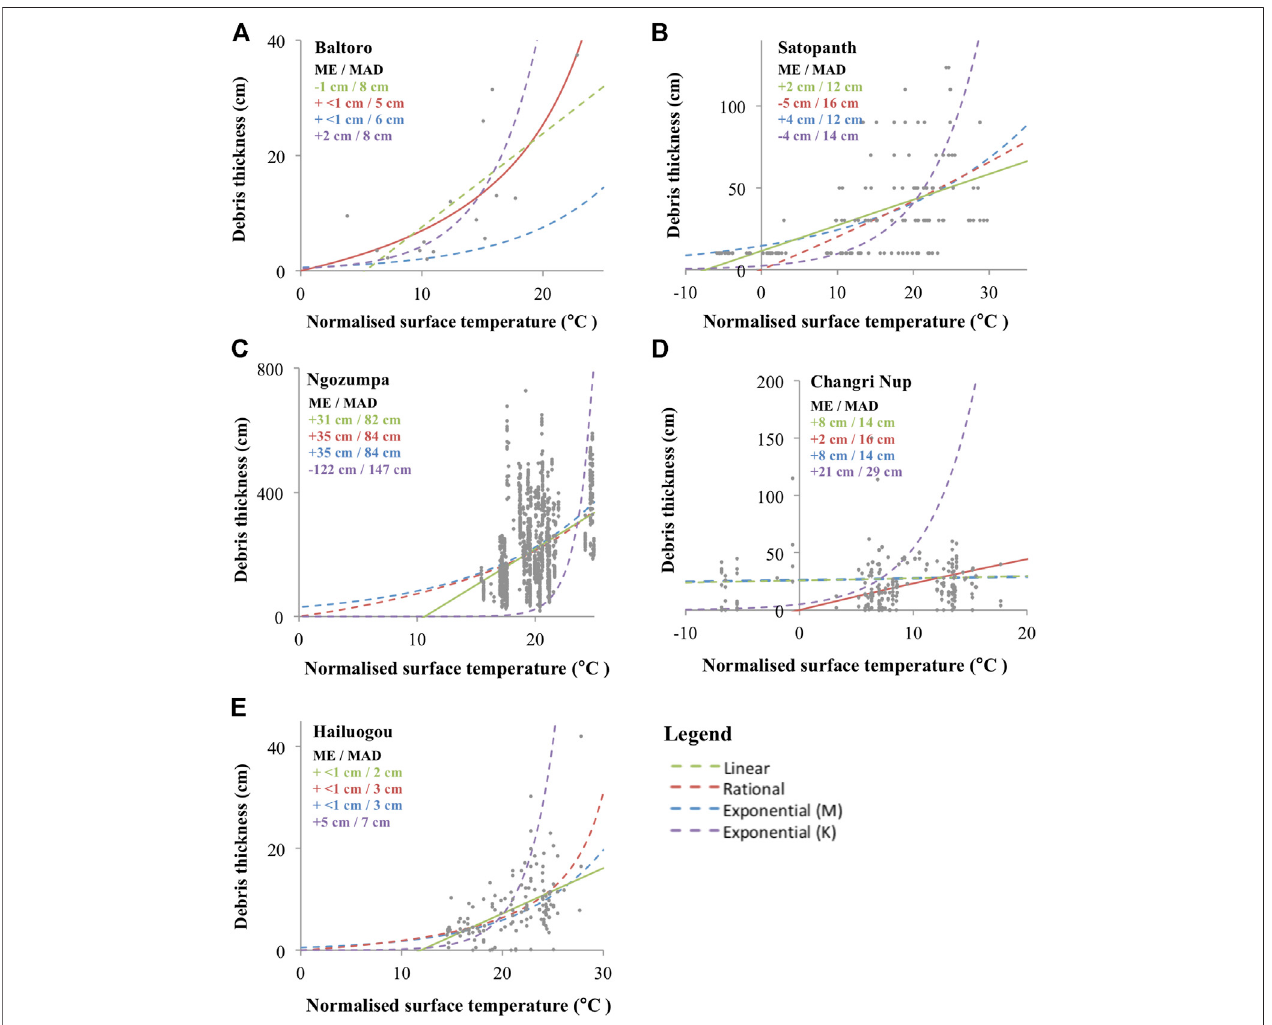
FIGURE 4 | Comparison of the errors of the linear (green), rational curve (red), exponential (M) (blue), and exponential (K) (purple) forms of the relationship between debris thickness and surface temperature for (A) Baltoro Glacier, (B) Satopanth Glacier, (C) Ngozumpa Glacier, (D) Changri Nup Glacier, and (E) Hailuogou Glacier. Circles represent data points, solid line indicates chosen relationship, dashed lines represent remaining relationships.